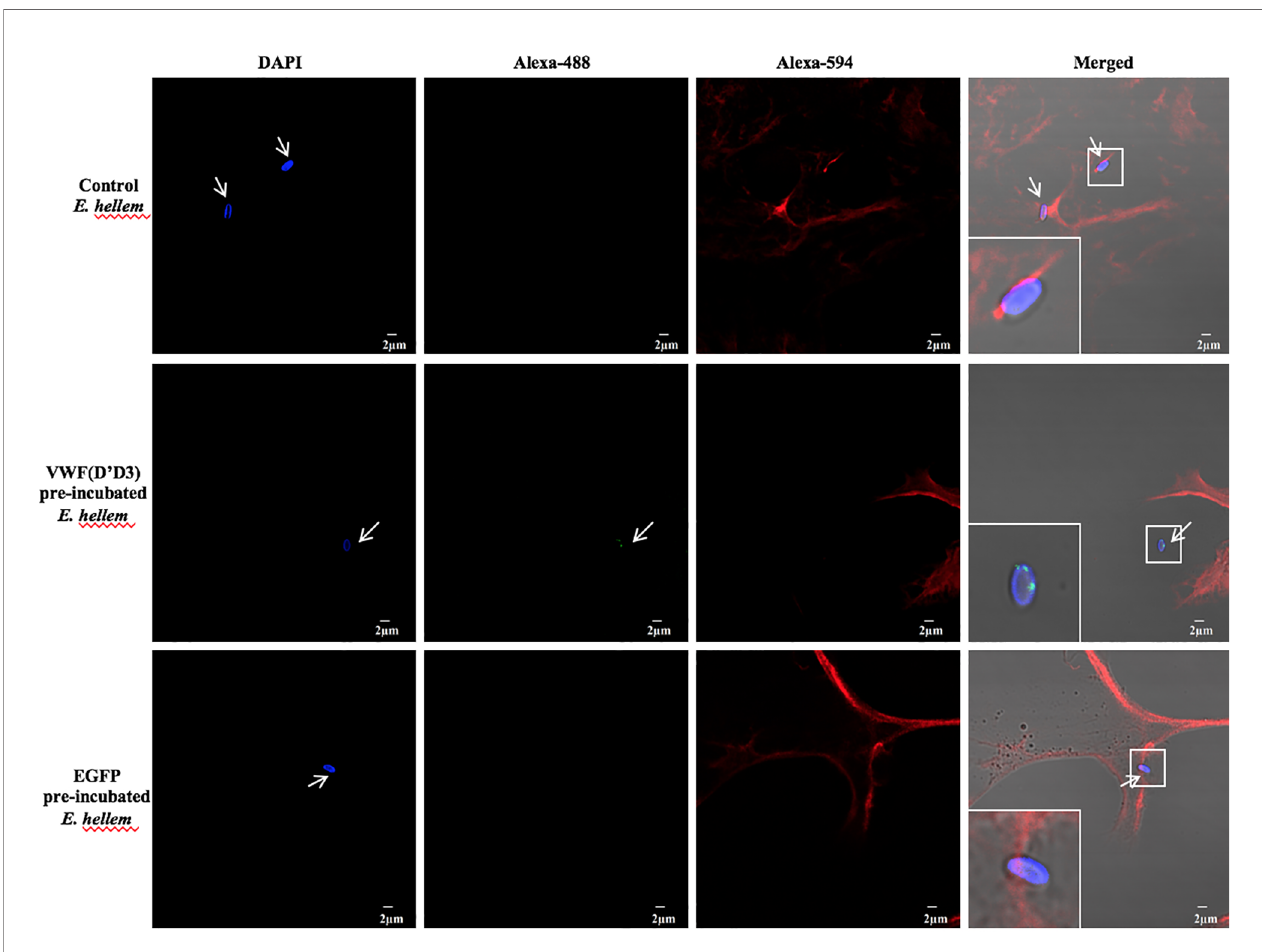
FIGURE 3 | VWF-D ’ D3 is key binding region for E. hellem . In micro fl uidic chamber, full length VWF (20 µg/ml) was perfused with shear stress of 5 dyn/cm 2 for 2 min. Same concentration (10 5 /ml) of either control (un-treated) E. hellem spores, VWF-D ’ D3 pre-incubated E. hellem spores, or EGFP pre-incubated E. hellem spores were then perfused through. The channels were then washed and fi xed. The E. hellem spores were visualized by DAPI (blue), and the pre-incubated VWF- D ’ D3 which has attached to E. hellem spores were visualized by anti-His antibody followed by Alexa 488-labeled secondary antibody (green). The VWF oligomers were visualized by anti-VWF antibody followed by Alexa 594-labeled secondary antibody (red). As shown by this immuno fl uorescence assay, untreated E. hellem spores or un-related EGFP treated E. hellem spores were both able to attach to the VWF oligomer strings (arrows, and also shown in enlarged views in upper and bottom rows). While VWF-D ’ D3 pre-incubation occupy the binding site of E. hellem , thus the spores could not bind with VWF strings (arrow, and also shown in enlarged view in middle